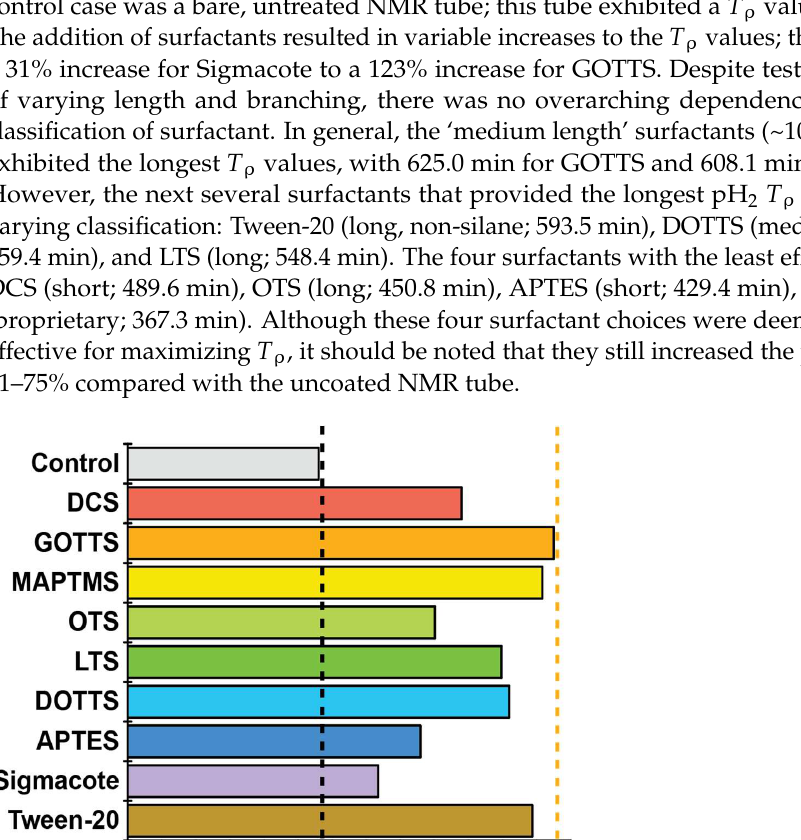
Figure 5. Plot comparing the ratio of integrals for the 586 cm −1 peak ( ortho ) vs. the 355 cm −1 peak ( para ) over time in a valved NMR tube coated with APTES. The initial 1-to-1 ratio denotes a 50/50 mixture of para and ortho spins, which slowly equilibrates to a 1-to-3 ratio of para vs. ortho upon reconversion.